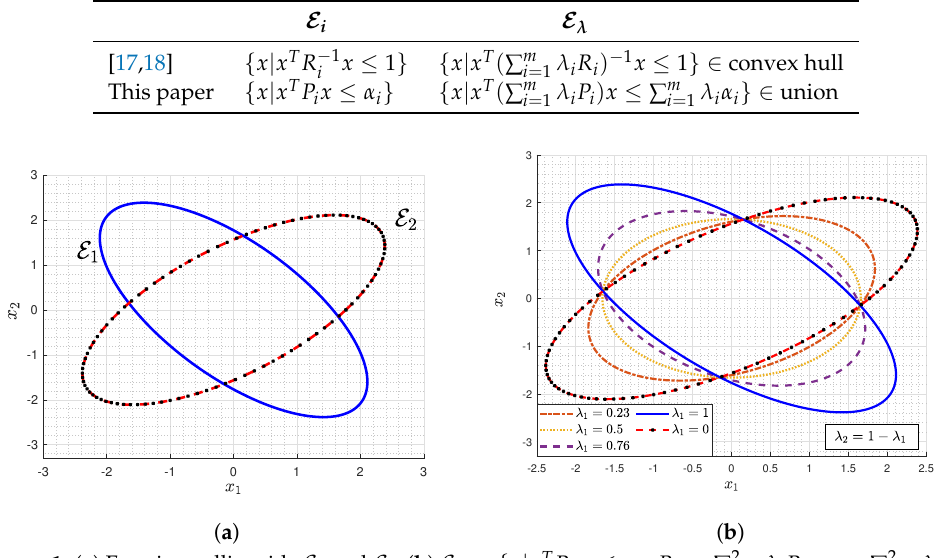
λ i P i , α λ = ∑ 2 λ i α i } i = 1 i = 1